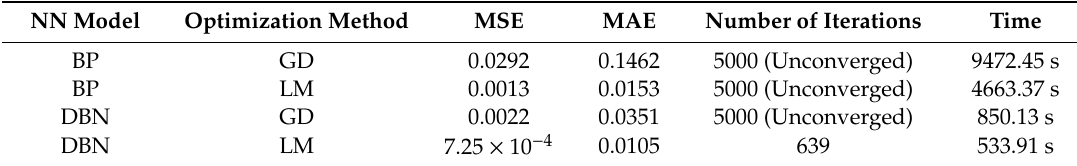
Table 1. Comparison of the prediction performance of neural network (NN) models.